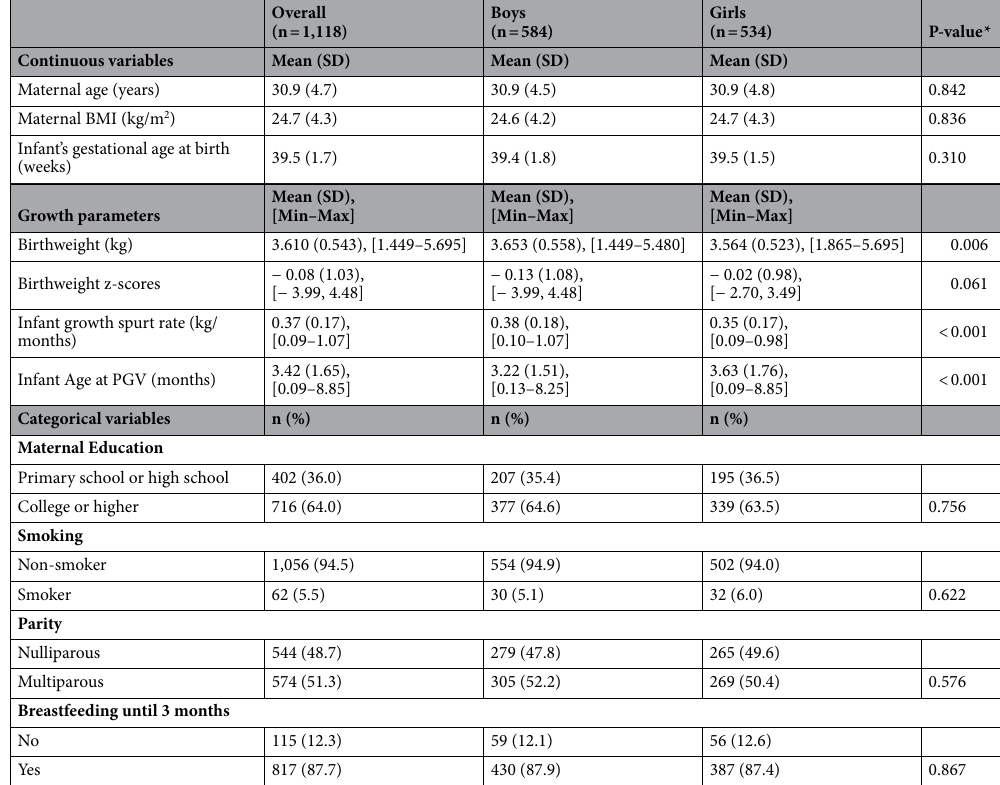
Table 1. Sociodemographic characteristics of the study population and children’s growth parameters, n = 1118. PGV = Peak growth velocity. * P-value from Student t-test for continuous variables and Chi-square test for categorical